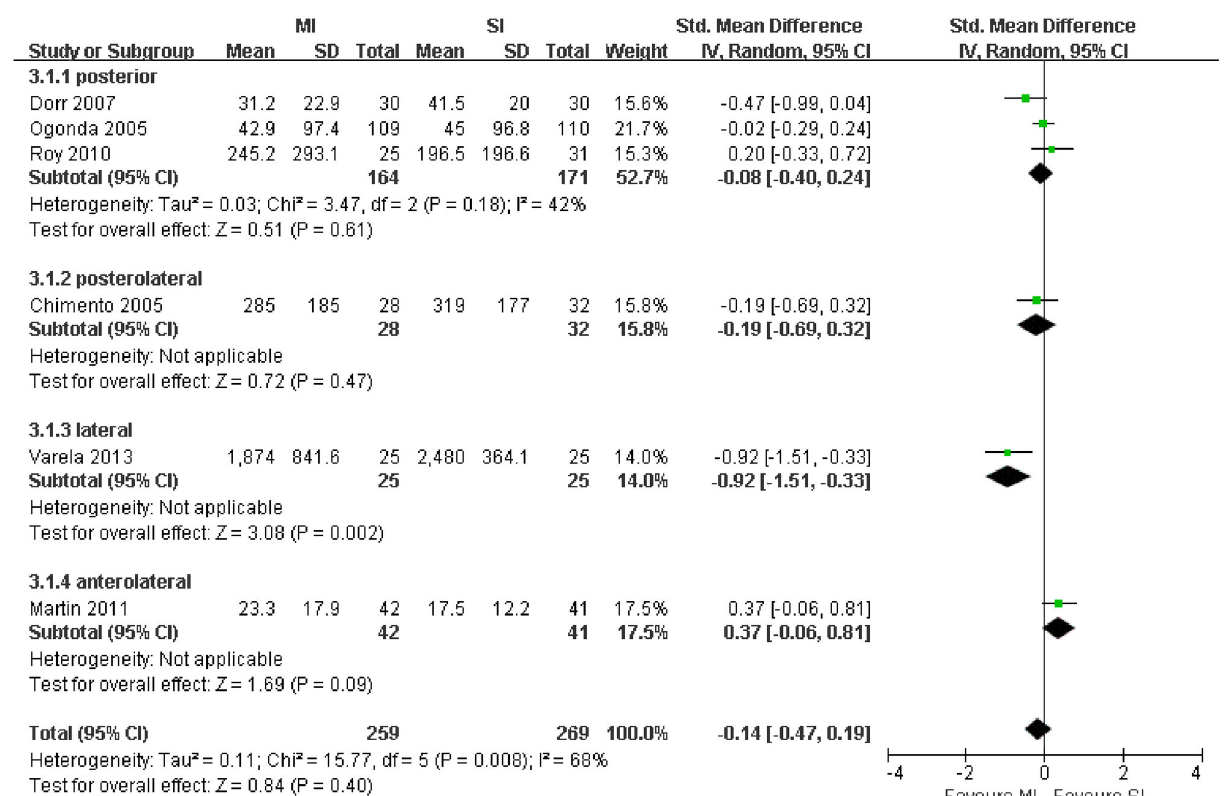
Figure 5. Meta-analysis of randomized controlled trials evaluating doses of pain medication. doi: